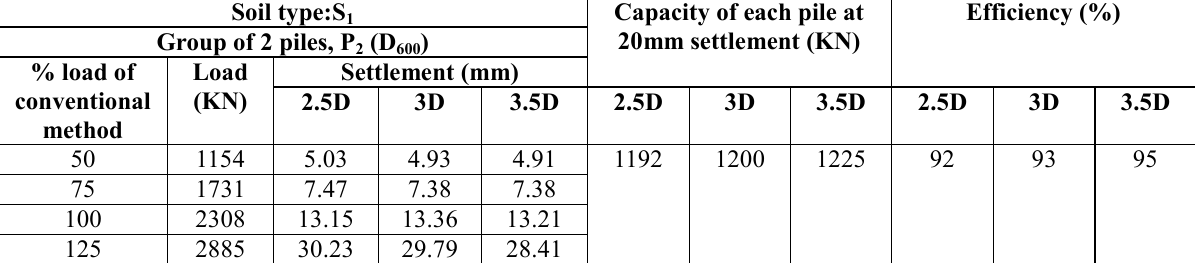
under different loads to find efficiency. [Mohr Coulomb Model]. 600